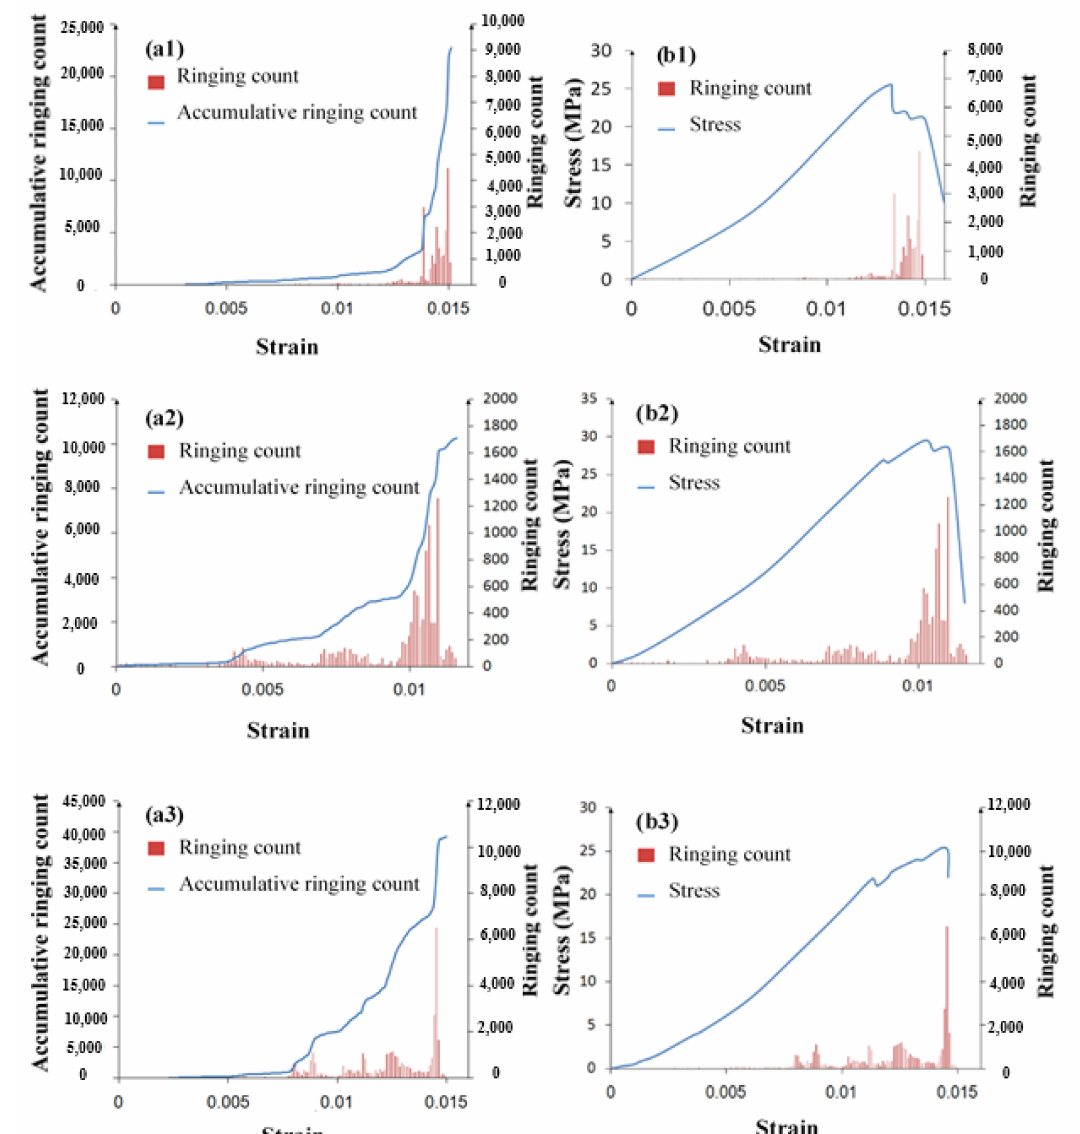
Figure 7. Relationships between AE (damage) characteristics and stress–strain curves of rock samples. ( a1 ) Accumulative ringing count (No. 1 rock sample); ( a2 ) Accumulative ringing count (No. 2 rock sample); ( a3 ) Accumulative ringing count (No. 3 rock sample); ( b1 ) Stress (No. 1 rock sample); ( b2 ) Stress (No. 2 rock sample); ( b3 ) Stress (No. 3 rock